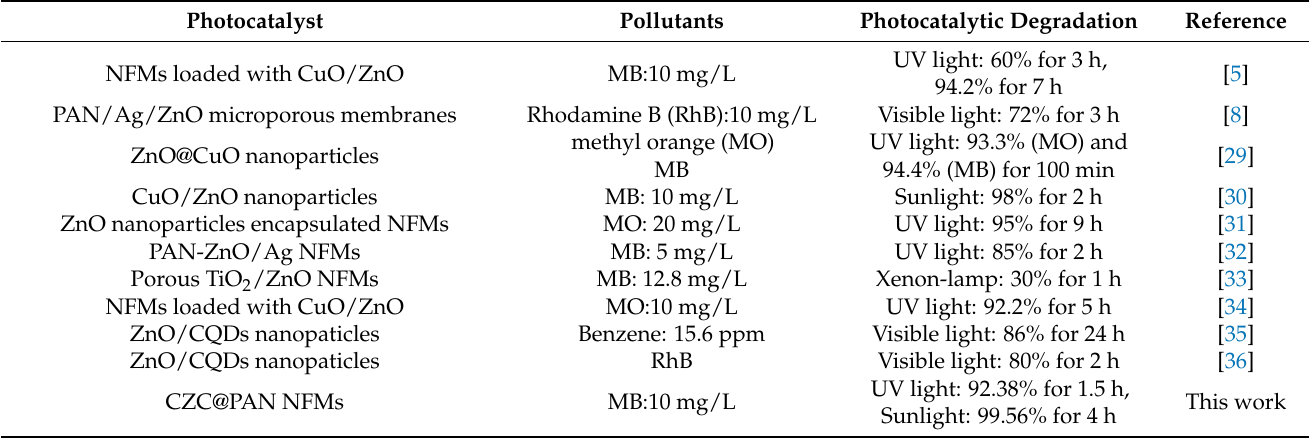
Table 1. Photocatalytic degradation activity of ZnO-based